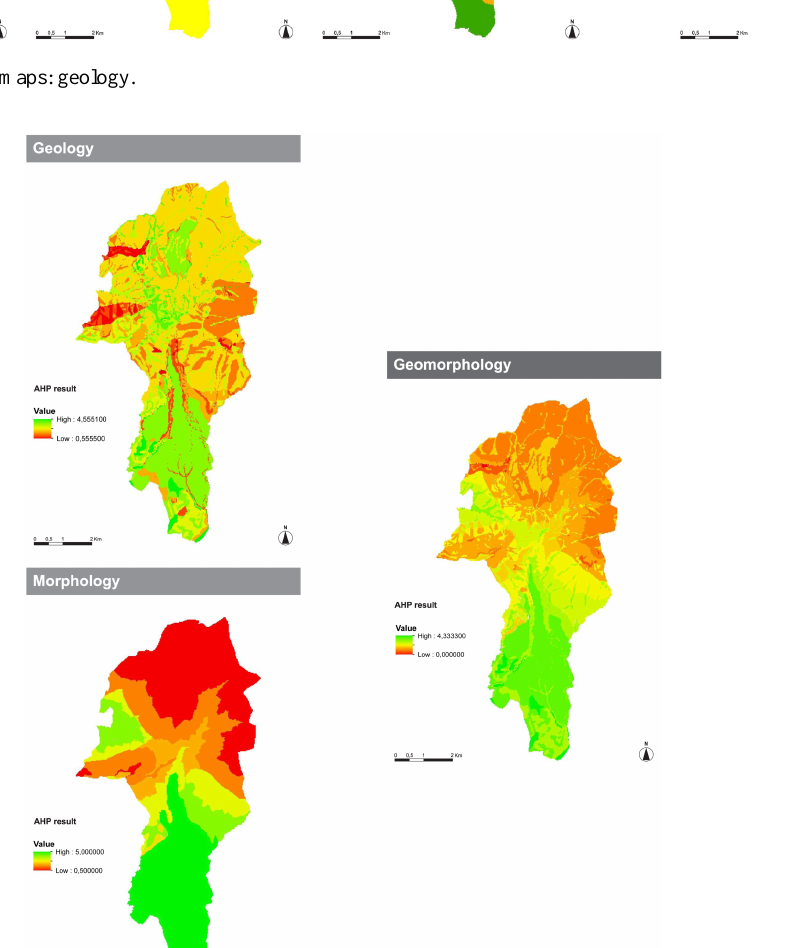
Fig. 4. Urbanization suitability maps: